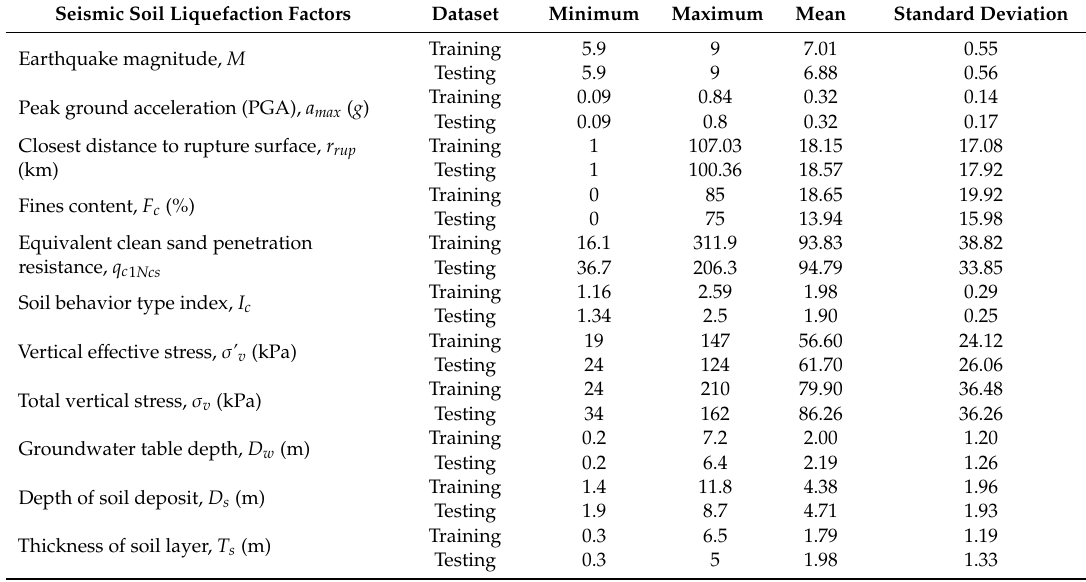
Table 3. Descriptive statistics of variables used in the model training and testing dataset. Seismic Soil Liquefaction